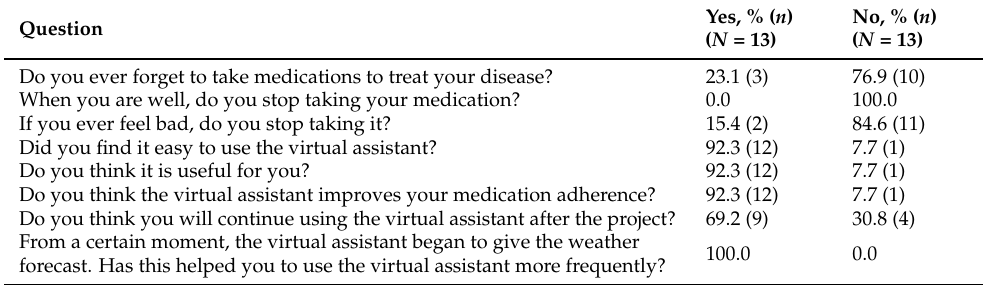
Table 7. Patients’ responses.